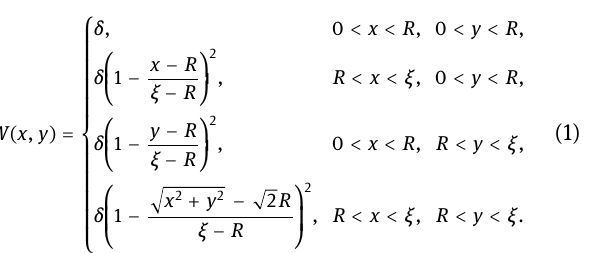
panel. It is found that the panel in contact with the RC wall ( lower panel ) hardly undergoes deformation. After the impact process is completed, the lower panel remains unchanged without local deformation.